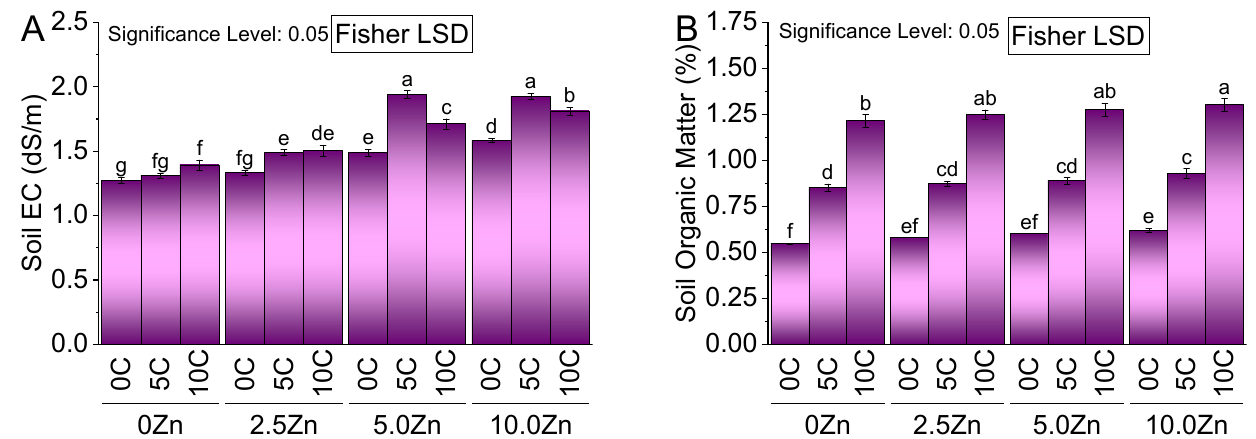
Figure 3. Impacts of various zinc application amounts (0, 2.5, 5.0 and 10.0 kg/ha) with different levels of compost (0, 5 and 10 t/ha) on soil EC ( A ) and soil organic matter ( B ) for wheat. Different letters above bars represent significant changes at p ≤ 0.05 using Fisher’s LSD test.